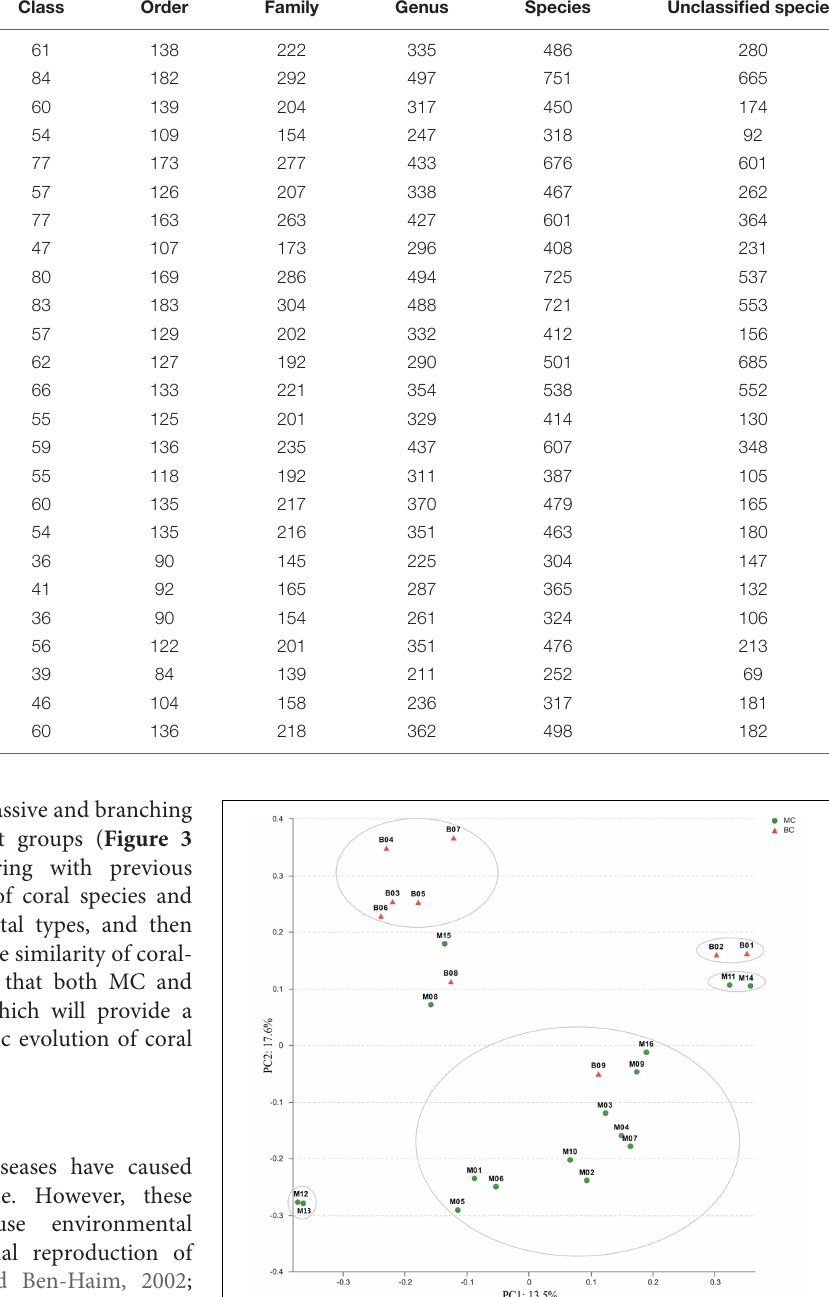
TABLE 3 | Numbers of bacteria associated with different skeletal morphologic corals in different taxonomic levels. Index